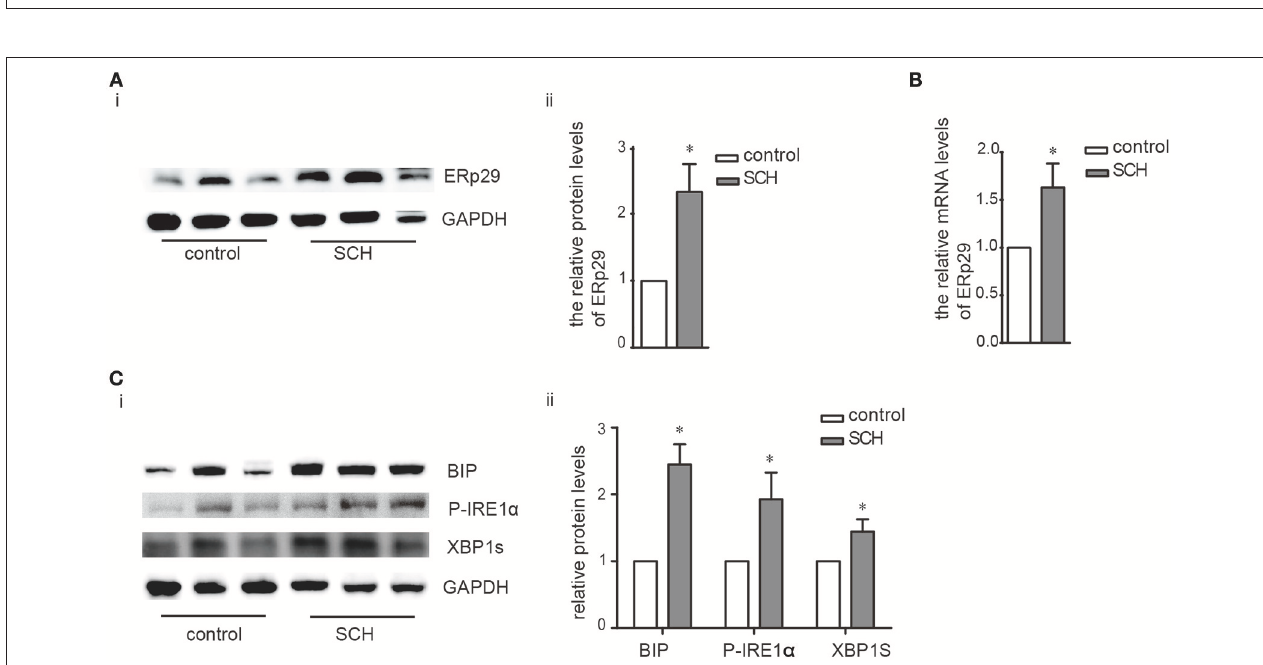
FIGURE 3 | Hepatic ER stress was induced in SCH mice. Male C57/BL6 mice were given methimazole (MMI, 0.08 mg/kg · BW · d, SCH group) or a corresponding volume of vehicle (control group) for 14 weeks, the expression of proteins in ERS pathway were detected by western blot ( n = 4–6). (A) The protein expression of ERq29 was detected by western blot. (B) The mRNA expression of ERq29 was detected by Real-time PCR. (C) The expression of proteins in the Bip/IRE1 α /XBP-1 pathway were detected by western blot. The data are presented as the mean ± SD. * p < 0.05 compared with control.